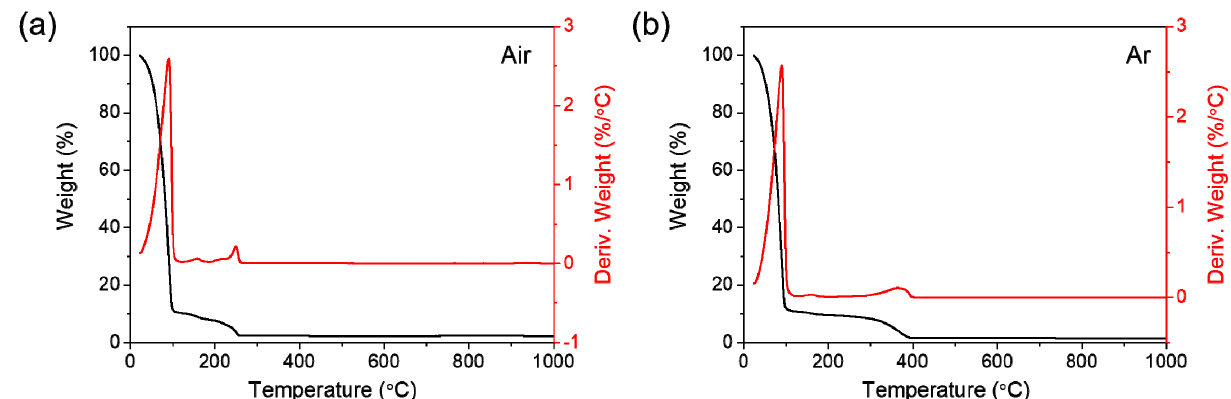
Figure 2. TGA and the derivative TGA curves of manganese 2-ethylhexanoate solution, acquired in ( a ) air and ( b ) Ar.